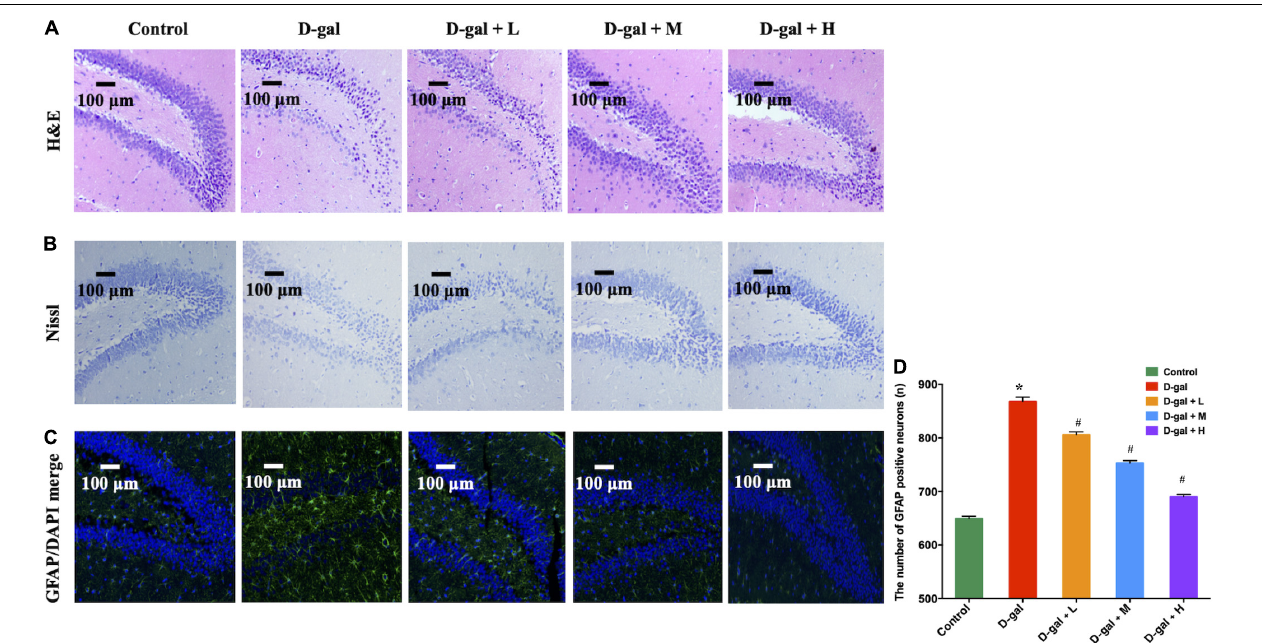
FIGURE 4 | The representative photomicrographs of H&E staining (A) , Nissl staining (B) and immunofluorescence staining of GFAP (green) (C,D) in the DG region of the hippocampus ( n = 4 in each group). In photomicrographs of immunofluorescence, astrocytes were positive for GFAP with ramified branches. The images of the scale bar represent 100 µ m, magnification = 200X. Values are presented as means ± SEM. * p < 0.05 when compared with the control group; # p < 0.05 when compared with the D-gal group. DG, dentate gyrus; GFAP, glial fibrillary acidic protein; SEM, standard error of